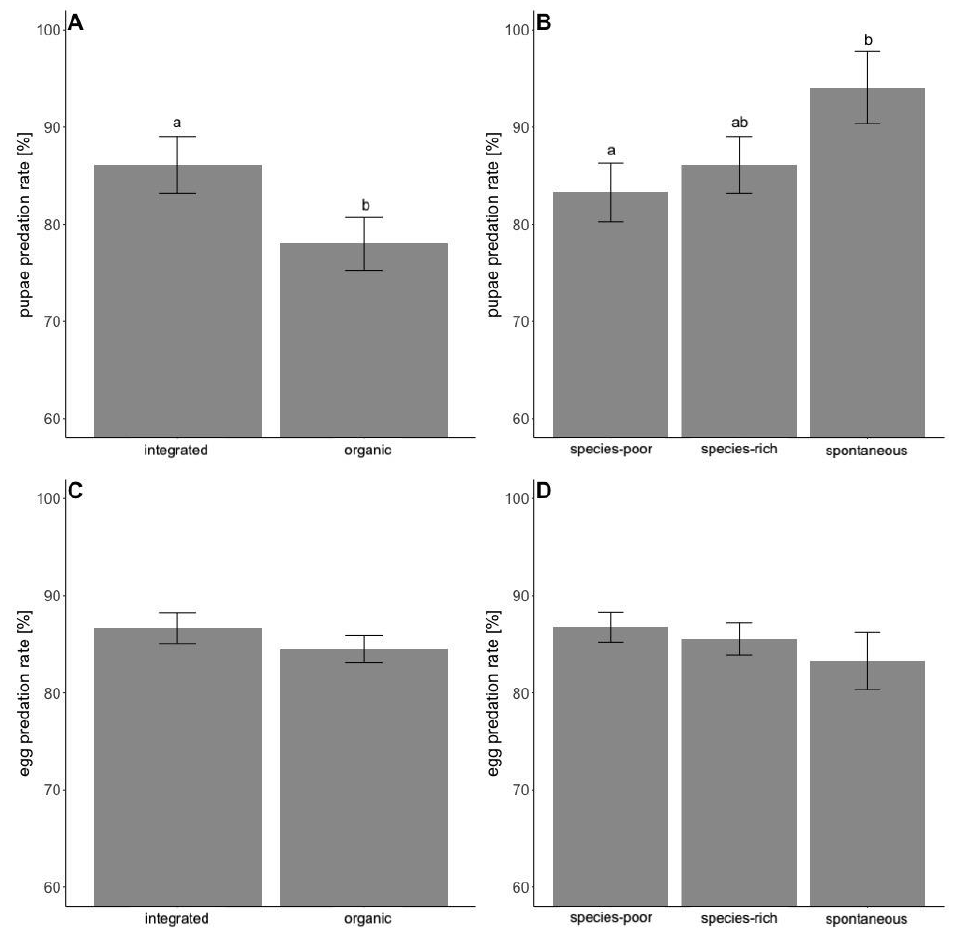
Figure 2. Differences in predation rates of L. botrana pupae ( A , B ) and eggs ( C , D ) between manage- ment systems ( A , C ) and implementation of cover-crops ( B , D ). Model predicted means and standard errors are displayed. Significant differences according to Tukey test are indicated by different letters.